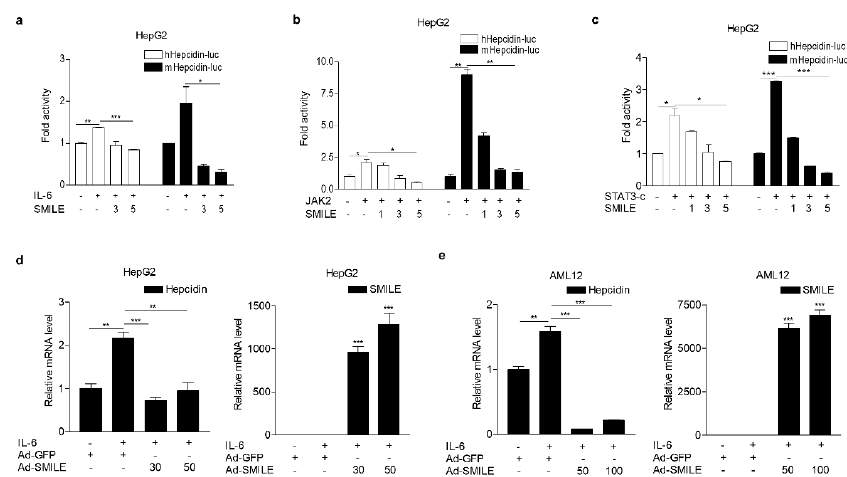
Figure 1. SMILE inhibits hepcidin expression by IL-6 signal. ( a ) Effect of SMILE on IL-6-induced hepcidin promoter activity. HepG2 cells were transfected with expression vectors encoding hepcidin promoters (hHpeicidn-luc; 100 ng or mHepcidin-luc; 200 ng) and pcDNA3-FLAG-hSMILE (3, 300 ng; 5, 500 ng) and then treated with IL-6 (20 ng/mL) for 12 h. ( b ) Effect of SMILE on JAK2-mediated hepcidin promoter activity. HepG2 cells were transfected with expression vectors encoding hepcidin promoters, JAK2 (+, 200 ng with hHepcidin-luc or 400 ng with mHepcidin-luc) and pcDNA3-FLAG-hSMILE (1, 100 ng; 3, 300 ng; 5, 500 ng). ( c ) Effect of SMILE on STAT3-induced hepcidin promoter activity. HepG2 cells were transfected with expression vectors encoding hepcidin promoters, STAT3-c (+, 200 ng with hHepcidin-luc or 500 ng with mHepcidin-luc) and pcDNA3-FLAG-hSMILE (1, 100 ng; 3, 300 ng; 5, 500 ng). ( d–e ) Inhibitory effect of SMILE on hepcidin mRNA expression. HepG2 cells ( d ) and AML12 cells ( e ) were infected with Ad-GFP (50, 100 MOI) or Ad-SMILE (30, 50, 100 MOI) for 36 h and then treated with IL-6 (20 ng/mL) for 12 h. All experiments were performed in duplicate or triplicate and repeated at least three times. The values are presented as means ± SD. * P < 0.05, ** P < 0.01, *** P < 0.001 using two-tailed Student’s t -test.